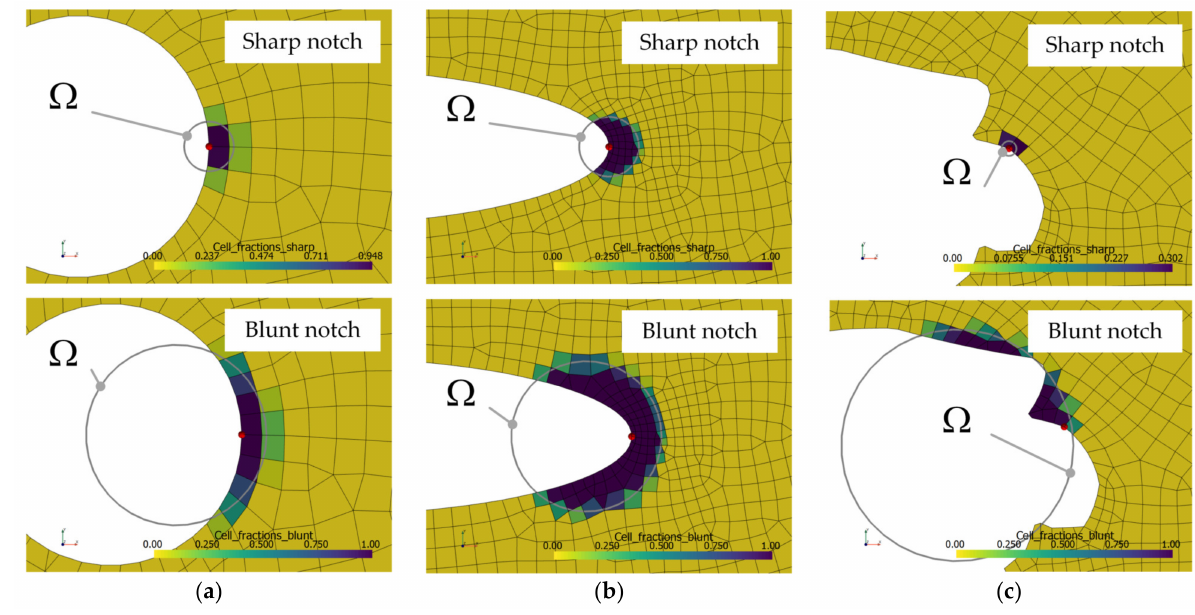
Figure 11. Fraction of cells at starting point for three defect geometries: ( a ) Circular hole-in-plate (mesh ‘circle_lin_R1mm_v1’); ( b ) Elliptical hole-in-plate (mesh ‘ellipsis_lin_rot0deg_v1’); and ( c ) Elon- gated defect (mesh ‘defect_elongated_lin_v1’).